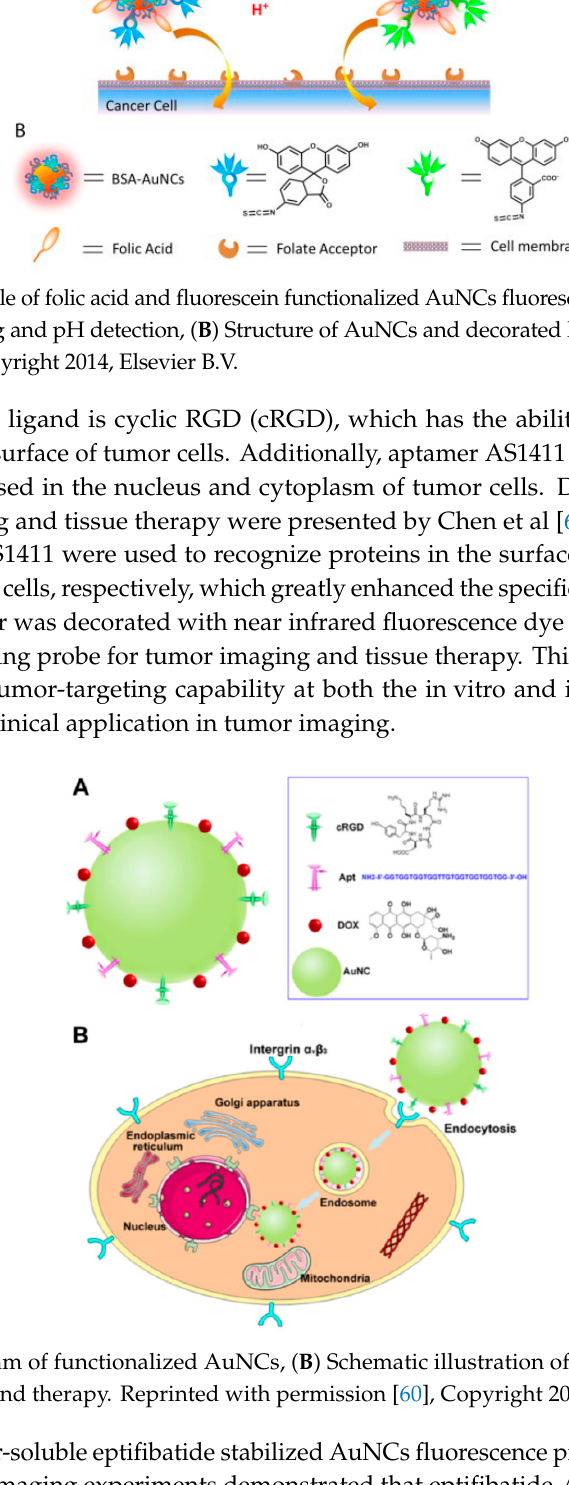
Figure 5. (A) Principle of folic acid and fluorescein functionalized AuNCs fluorescent biosensor for cancer cell-targeted imaging and pH detection, (B) Structure of AuNCs and decorated ligands. Reprinted with permission [56]. Copyright 2014, Elsevier B.V.